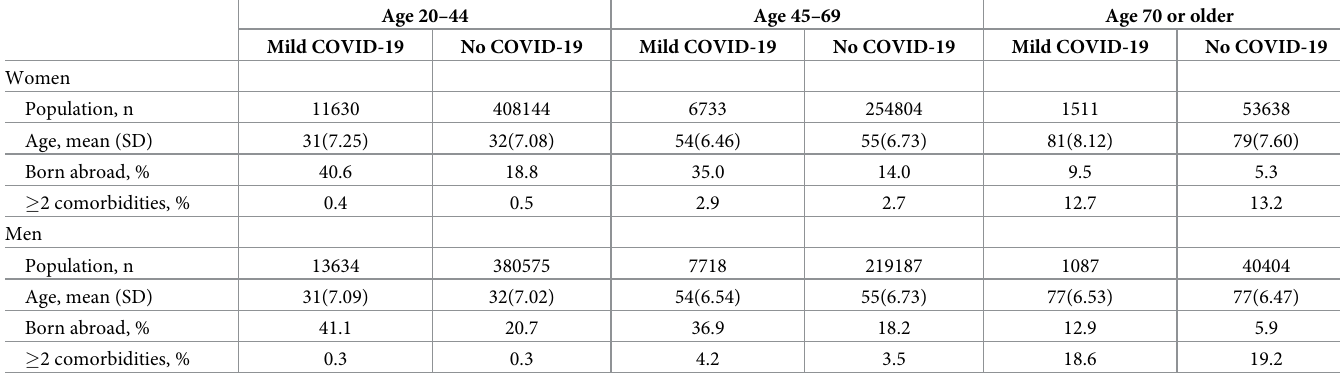
Table 1. Descriptive